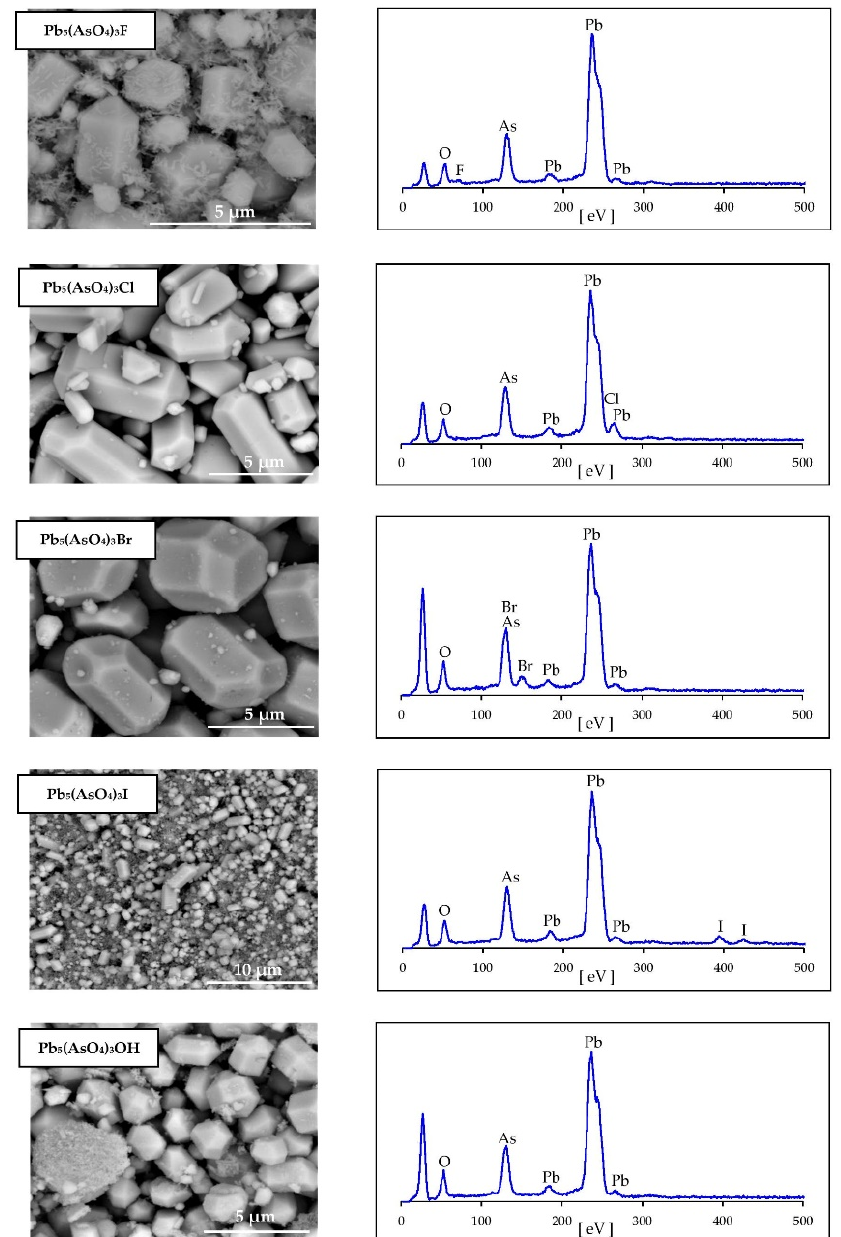
Figure 1. Scanning electron micrographs and EDS elemental analysis of synthesized halogenated mimetites. Unlabeled peak at low eV on EDS spectra is an artifact of mounting (carbon tape).